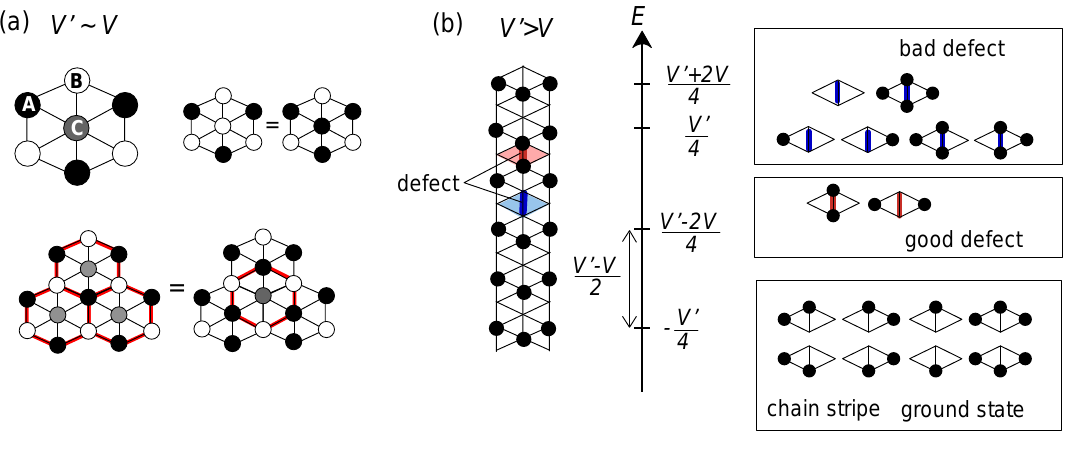
Figure 7. Energetics of the classical Ising model (Equation (3)) on the anisotropic triangular lattice. ( a ) Hexagonal unit of the three-sublattice state (ABC), and three adjacent hexagons. Flipping the center of the hexagon from black to white does not change the energy, and this operation generates numerous contingent states; ( b ) Energy diagram of the unit plaquette at V (cid:48) > V . The plaquettes of the excited energy ( V (cid:48) − V ) / 2 form a series of low energy “good /N , as shown in Figure 6. defect” states classified by the defect number N d